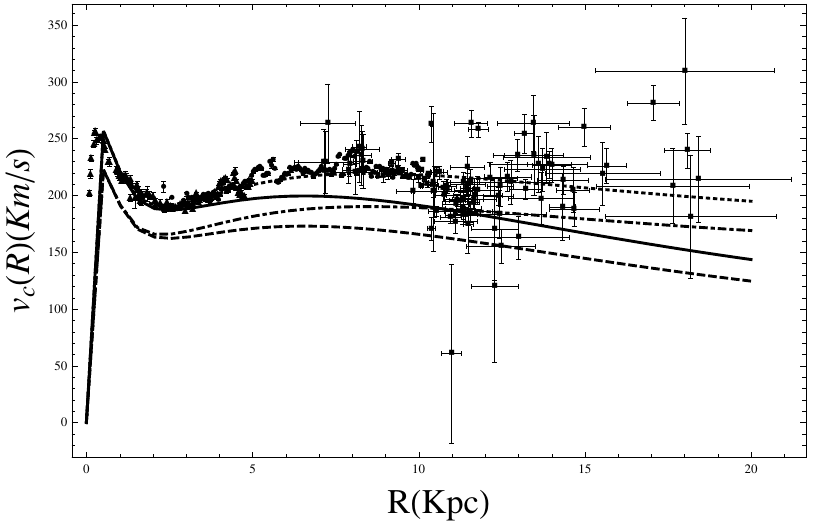
Figure 8. Superposition of theoretical behaviors (GR (dashed line), GR + DM (dashed and dotted line), FOG (solid line), FOG + DM (dotted line)) on the experimental data for Milky Way. The mass model used is shown in Equation (88) and the values of parameters are in = 10 − 2 Kpc − 1 and µ = 10 2 Kpc − 1 Table 1. The values of “masses” are µ 1 2